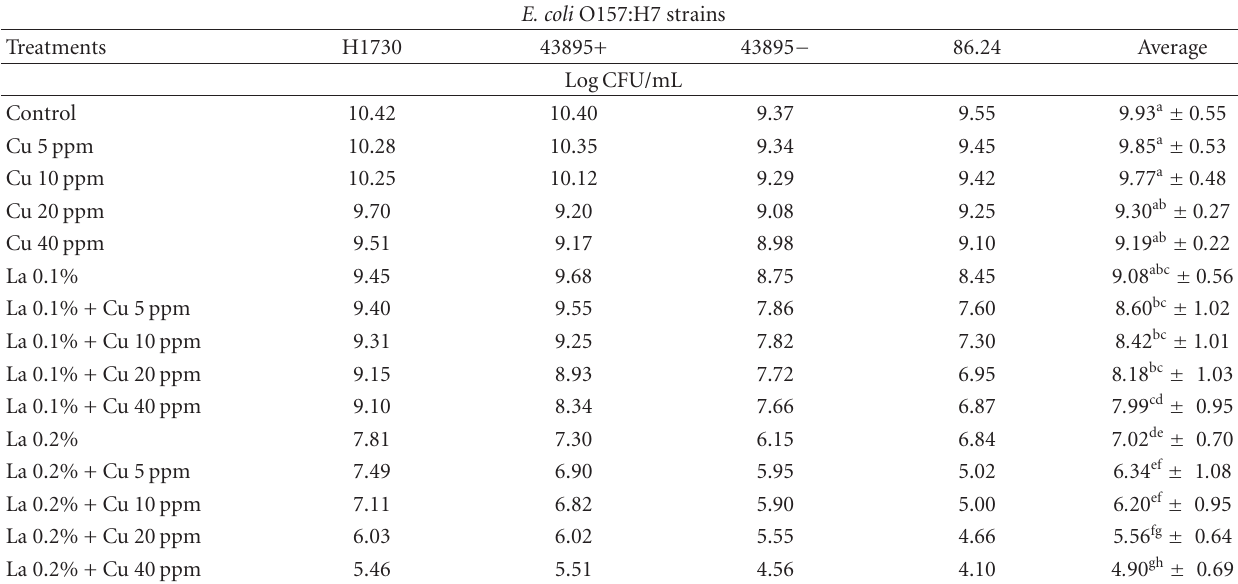
Means ( ± standard deviation) within the same column not followed by same letters are significantly di ff erent ( P < 0 . 05). Initial bacterial population was approximately 3.00logCFU/mL.